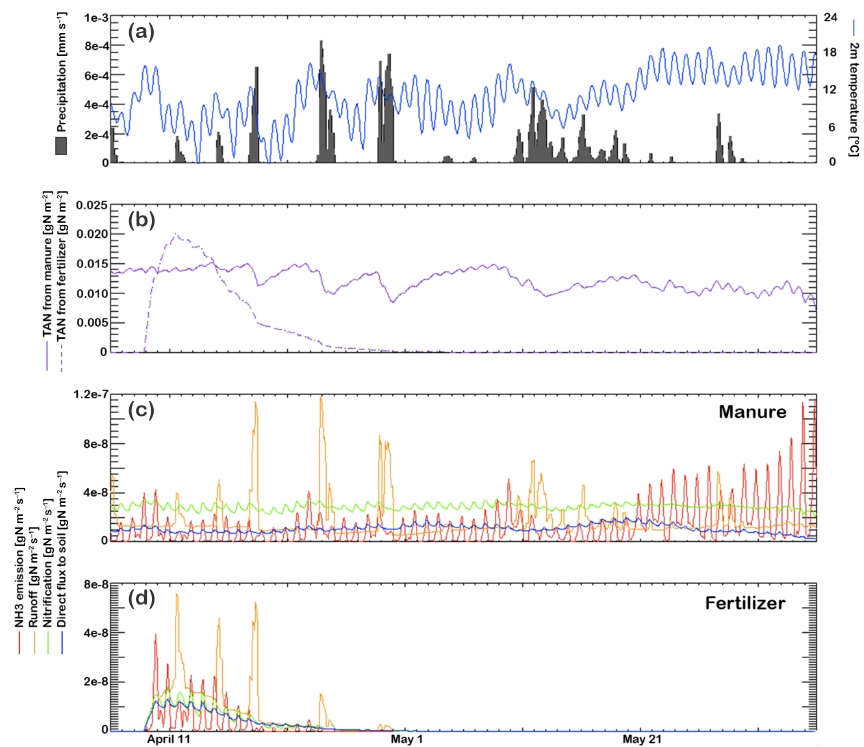
Figure 12. Site-specific pathways for nitrogen budget at 35 ◦ N and 100 ◦ W, near the Texas panhandle. Panels show (a) the temperature ( ◦ C) and precipitation (mms − 1 ) used to force the CLM, (b) the manure (solid) and synthetic fertilizer TAN pools (dashed) (gNm − 2 ) , and the four major loss pathways (gNm 2 s − 1 ) from (c) the manure TAN pool (d) the synthetic fertilizer TAN pool. Loss pathways: NH 3 emissions, red; runoff, orange; nitrification, green; and diffusion to the soil,